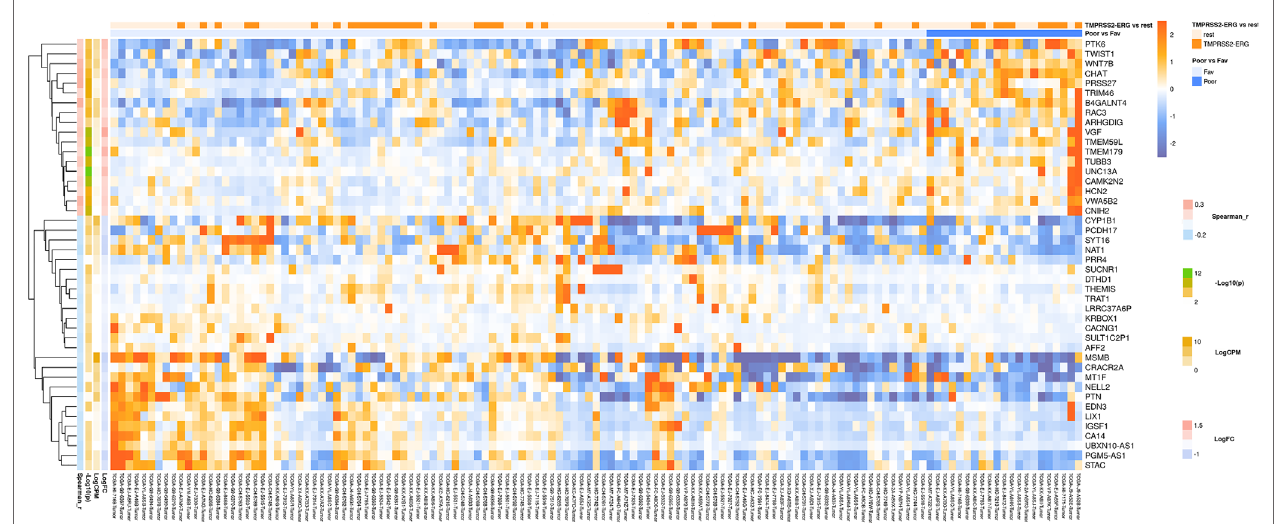
FIGURE 1 | Heatmap demonstrating log relative expression level of top differentially expressed genes between the groups of adverse and favorable prognosis (TCGA data). Cell colors (blue-white-orange gradient) correspond the binary logarithm of the ratio of the expression level in a current sample to the average level across all the samples (per each gene). Blue - expression level is below the average, orange - above the average. Spearman_r—Spearman’s rank correlation coefficient. -Log10( p ) is the negative logarithm of DESeq’s p -value. LogCPM—average binary logarithm of read counts per million (CPM). LogFC—binary logarithm of expression level fold change (samples with adverse prognosis compared to favorable